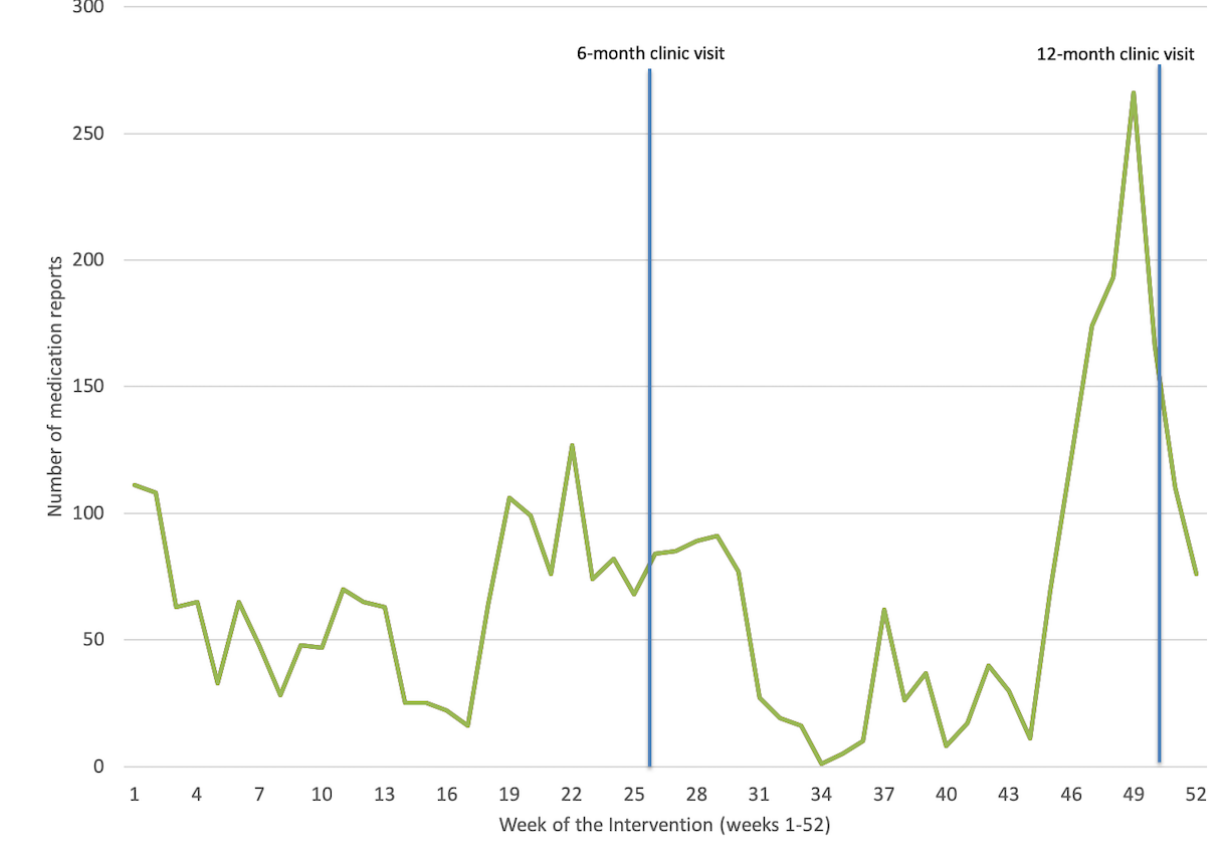
Figure 8. Self-reported controller medication use showing the effect of clinic visits (surveillance effect) on self-reporting behavior (clinic visits were scheduled at 6 and 12 months from the beginning of the intervention).